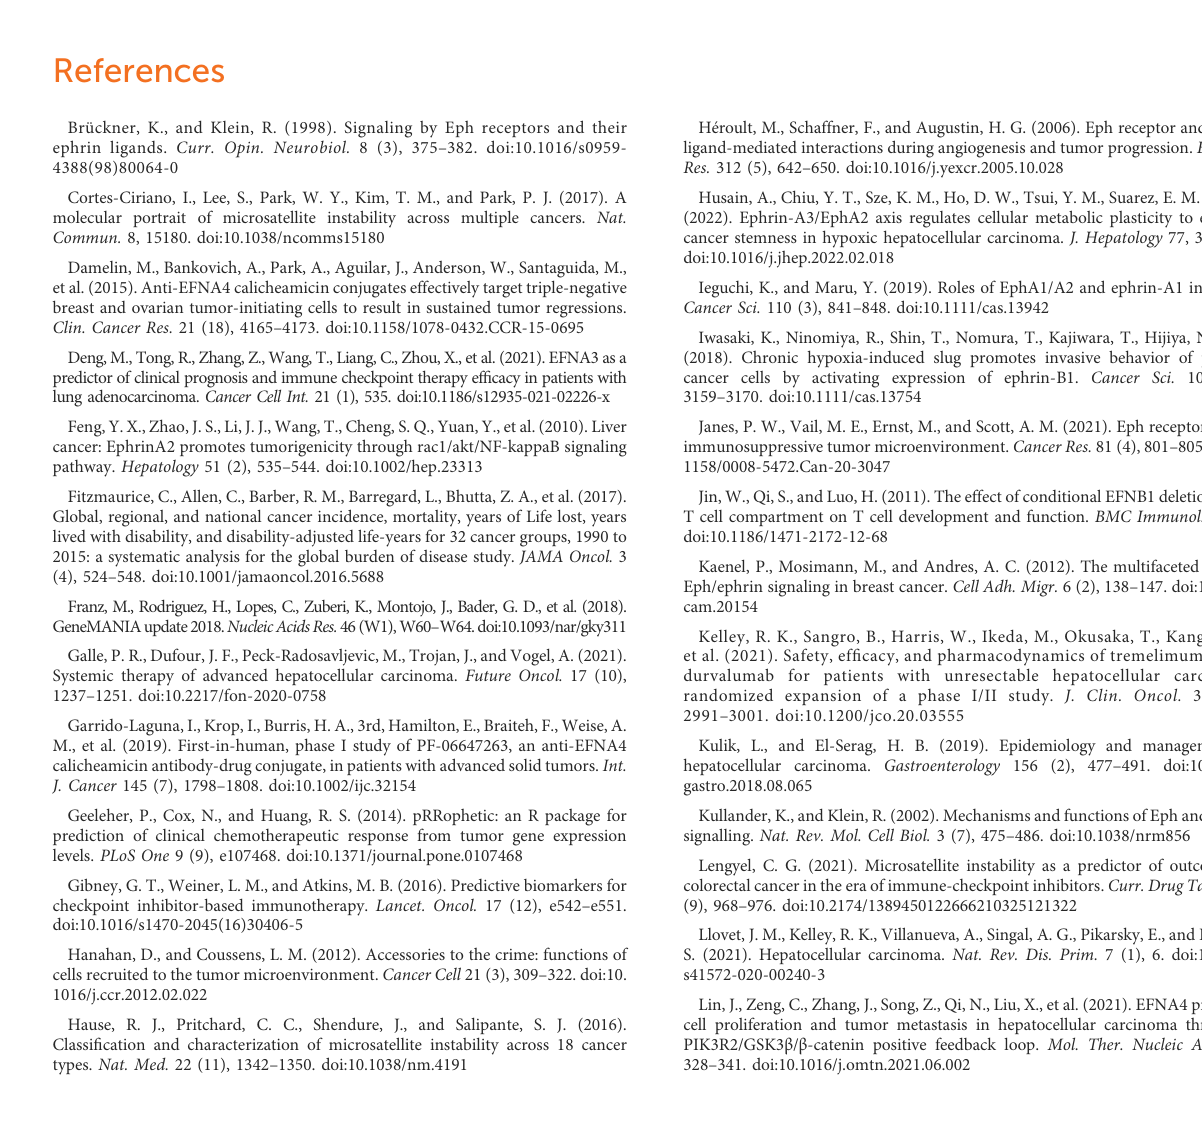
SUPPLEMENTARY FIGURE S2 Association of ephrin expression with progression-free interval (PFI) (A) and disease-speci fi c survival (DSS) (B) in HCC based on Kaplan – Meier analysis. SUPPLEMENTARY FIGURE S3 Correlation between EFNA3 and tumor-in fi ltrating immune cells in HCC based on the XCELL, QUANTISEQ, MCPCOUNTER, EPIC, CIBERSORT- ABS, and CIBERSORT algorithms. SUPPLEMENTARY FIGURE S4 Correlation between EFNA4 and tumor-in fi ltrating immune cells in HCC based on the XCELL, QUANTISEQ, MCPCOUNTER, EPIC, CIBERSORT- ABS, and CIBERSORT algorithms. SUPPLEMENTARY FIGURE S5 Correlation between EFNB1 and tumor-in fi ltrating immune cells in HCC based on the XCELL, QUANTISEQ, MCPCOUNTER, EPIC, CIBERSORT- ABS, and CIBERSORT algorithms. SUPPLEMENTARY FIGURE S6 Correlation between prognosis-related ephrin gene expression and gene mutational landscapes. (A) EFNA3; (B) EFNA4; and (C)